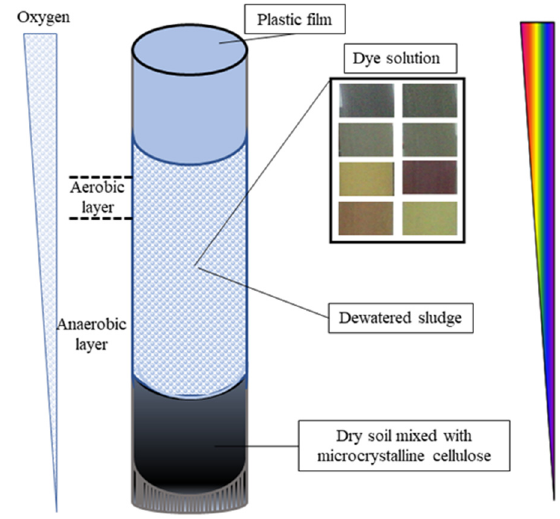
Figure 1. Experimental setup: Winogradsky column showing aerobic and anaerobic layers of dewatered sludge zone. Eight different dye solutions (methyl orange, methyl red, orange I, orange G, tartrazine, alizarin yellow R sodium salt, mixture and control) were used to inoculate the dewatered sludge. The rainbow spectrum shows the light penetration.